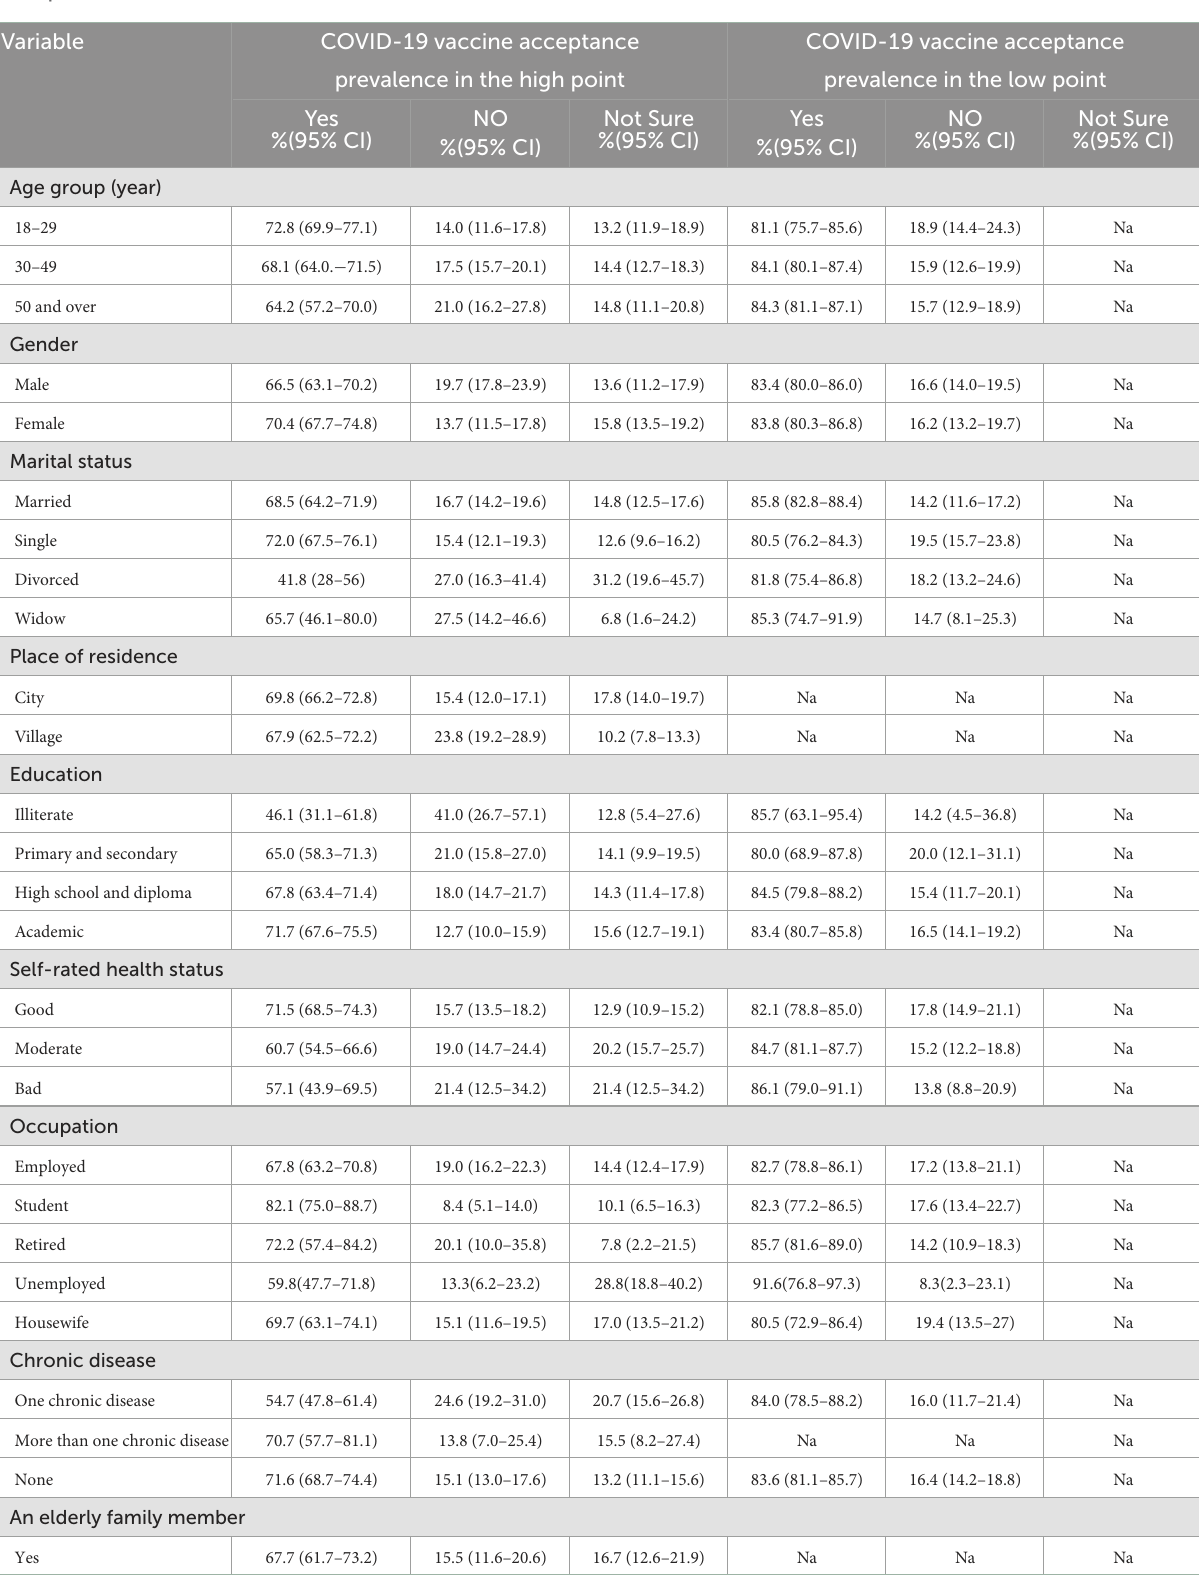
TABLE 3 Acceptance, uncertainty, and definite unwillingness to receive the COVID-19 vaccine at the high and low points of the epidemic based on participants’ baseline variables.